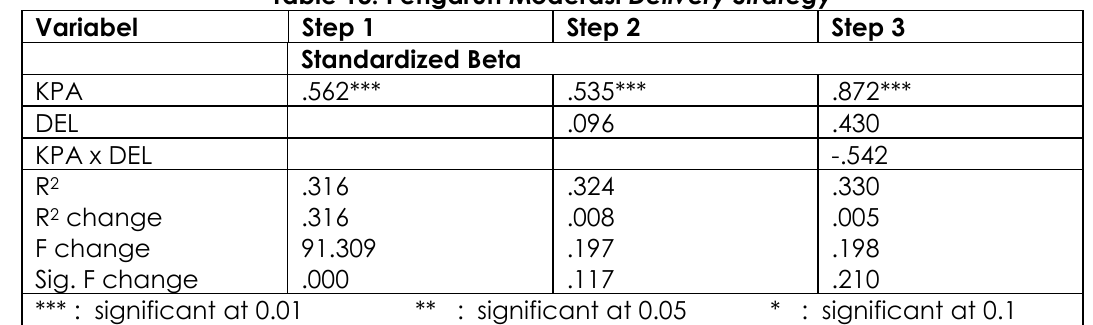
Table 13: Pengaruh Moderasi Delivery